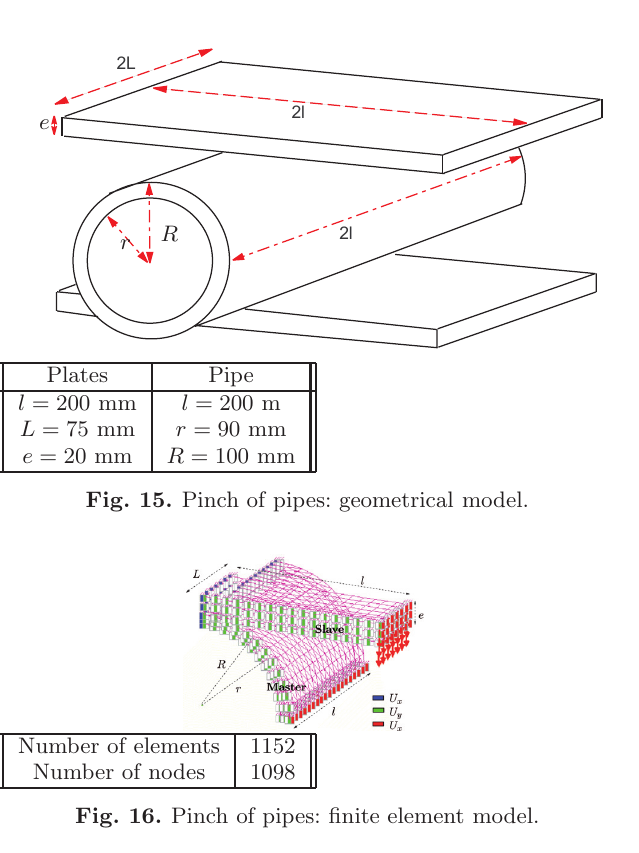
– Poisson ration: ν = 0 . 30 . –